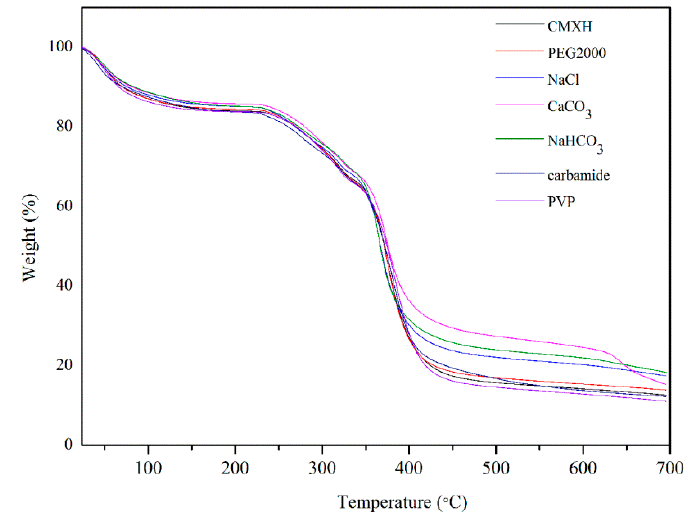
Figure 3. Thermogravimetric curves of the seven kinds of hydrogels.